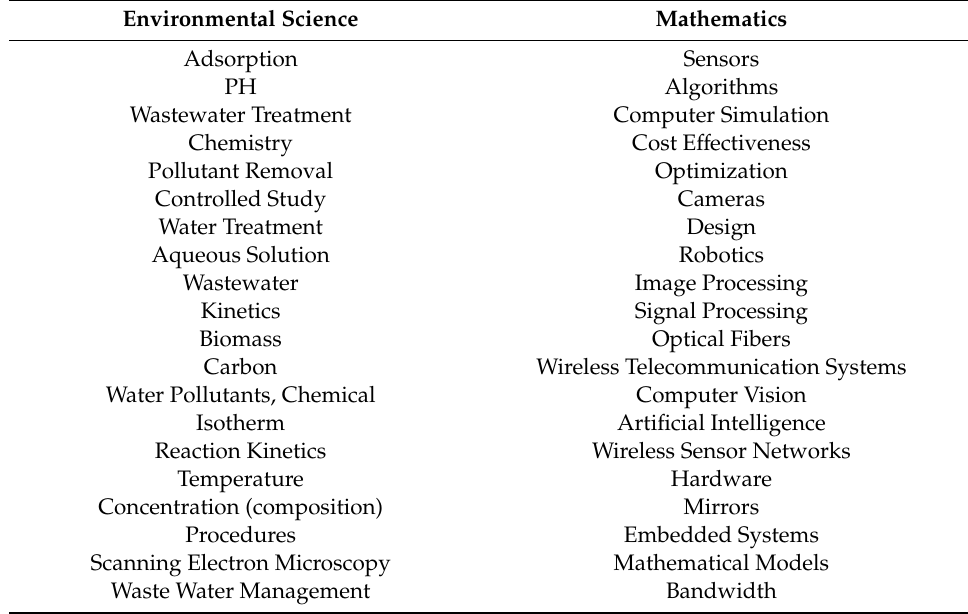
Table 11. Keywords on low cost research for the categories 9 and